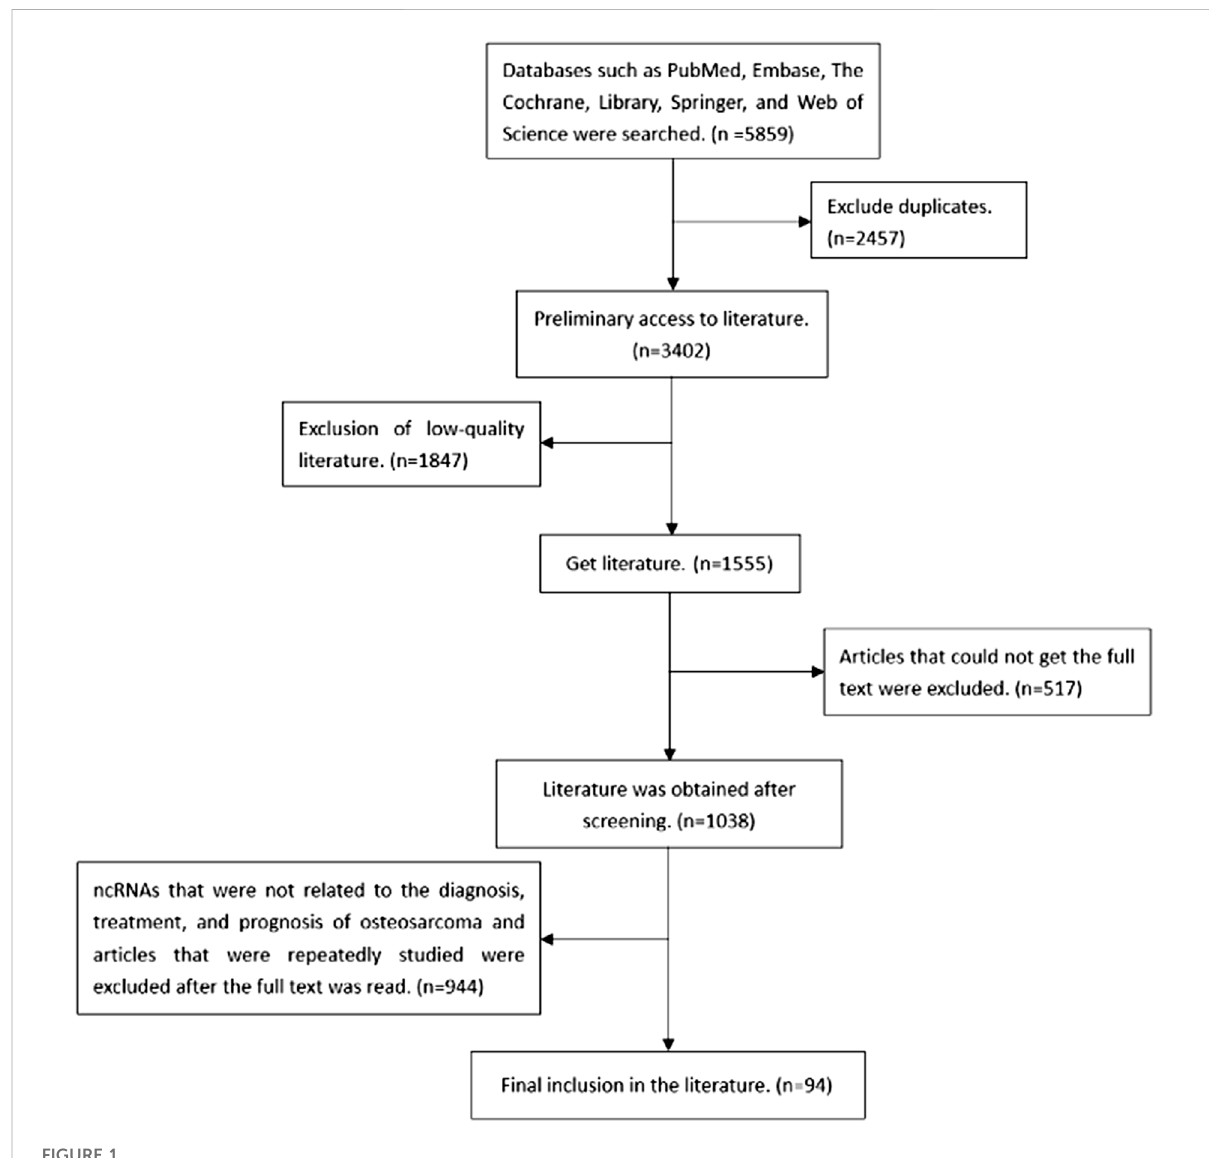
FIGURE 1 Flow chart of literature selection and